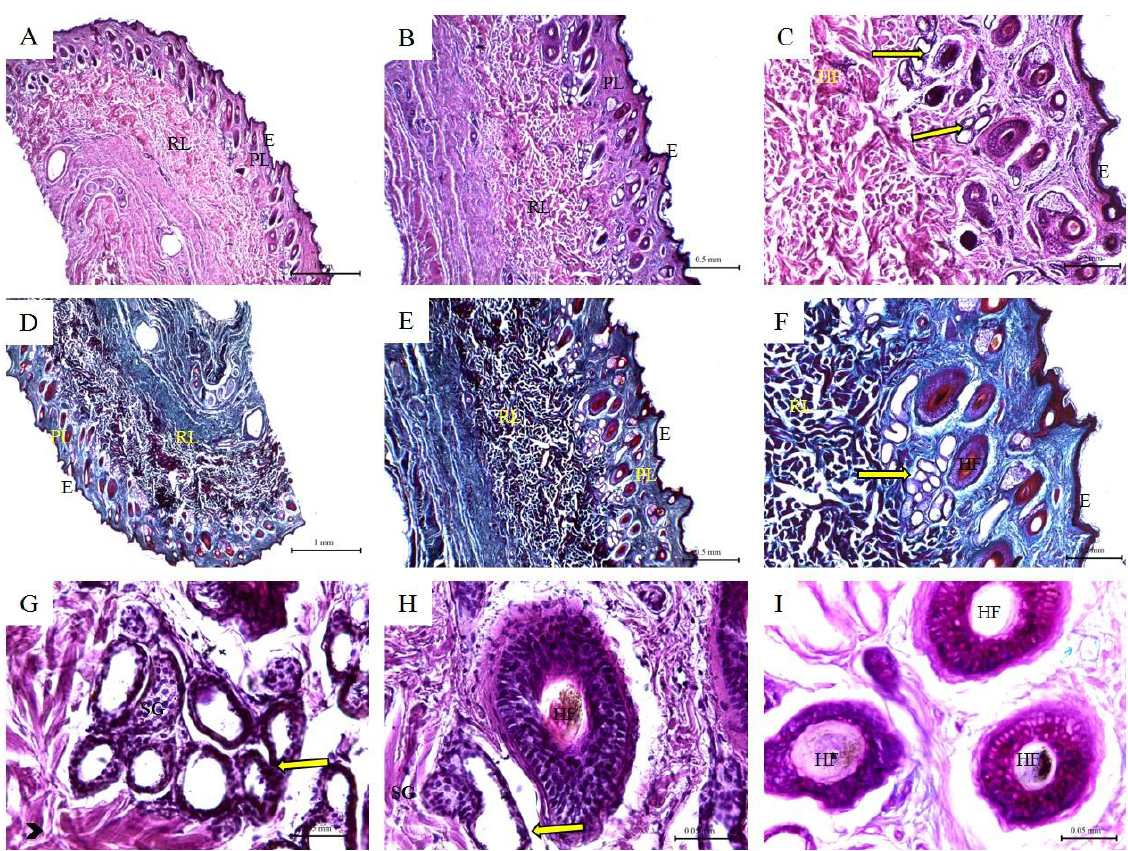
Figure 7: Histological features of donkey skin. Hematoxylin and eosin staining ( A-C ; G-H) ; Cross- man's trichrome staining ( D-F) ; and PAS staining ( I ) of donkey skin tissue sections. (E) Keratinized stratified squamous epithelium of the epidermis; (PL) Papillary layer of the dermis; (RL) Reticular layer of the dermis; (SG) Sebaceous glands; (Arrow heads) collagen bundles of the reticular layer; (Yellow arrow) Sweat glands; (HD) hypodermis; (HF) Primary follicle of the compound hair sur- rounded by secondary follicles. Table 1: Differential histological features of the skin of buffalo, cow, camel, sheep, goat, dog, and donkey Animal species Feature Buffalo Cow Camel Goat